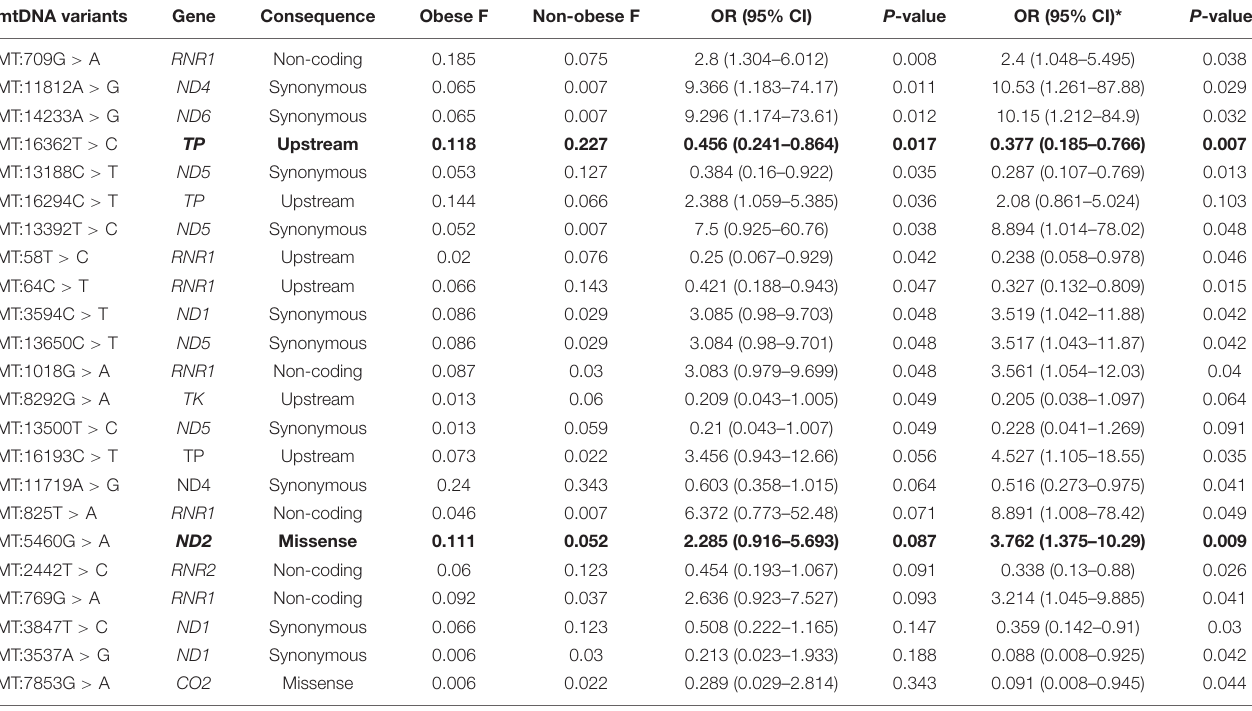
TABLE 3 | Mitochondrial variants associated with obesity in the Kuwaiti